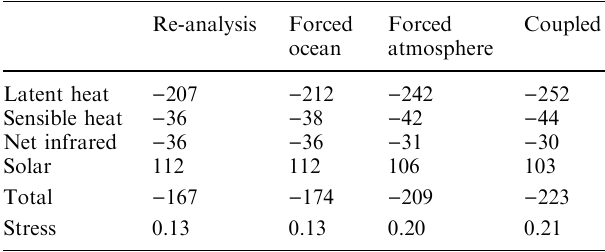
Table 1. Simulated and ‘re-analyzed’ surfaces fluxes